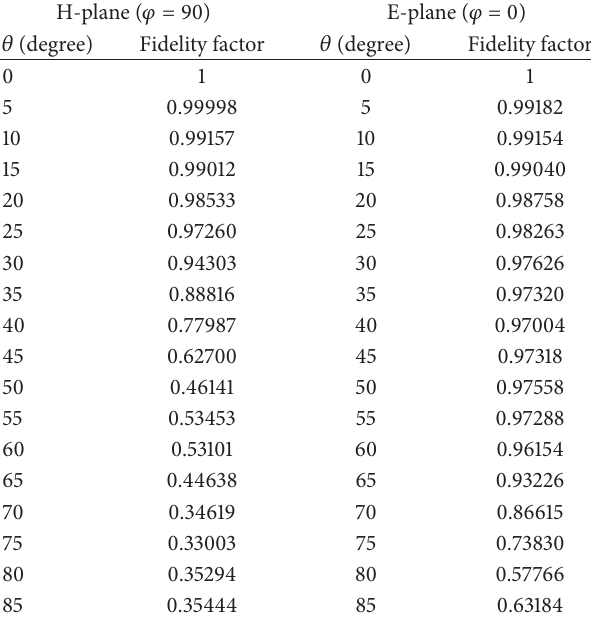
Table 2: Computed fidelity factor of theoriginal antenna in H-plane and E-plane.